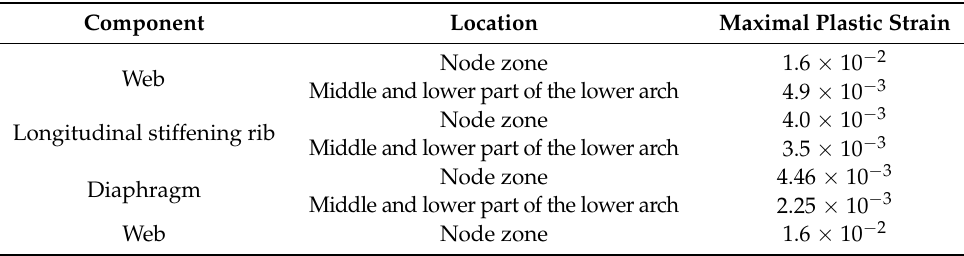
Table 3. Maximal plastic strain in each location.